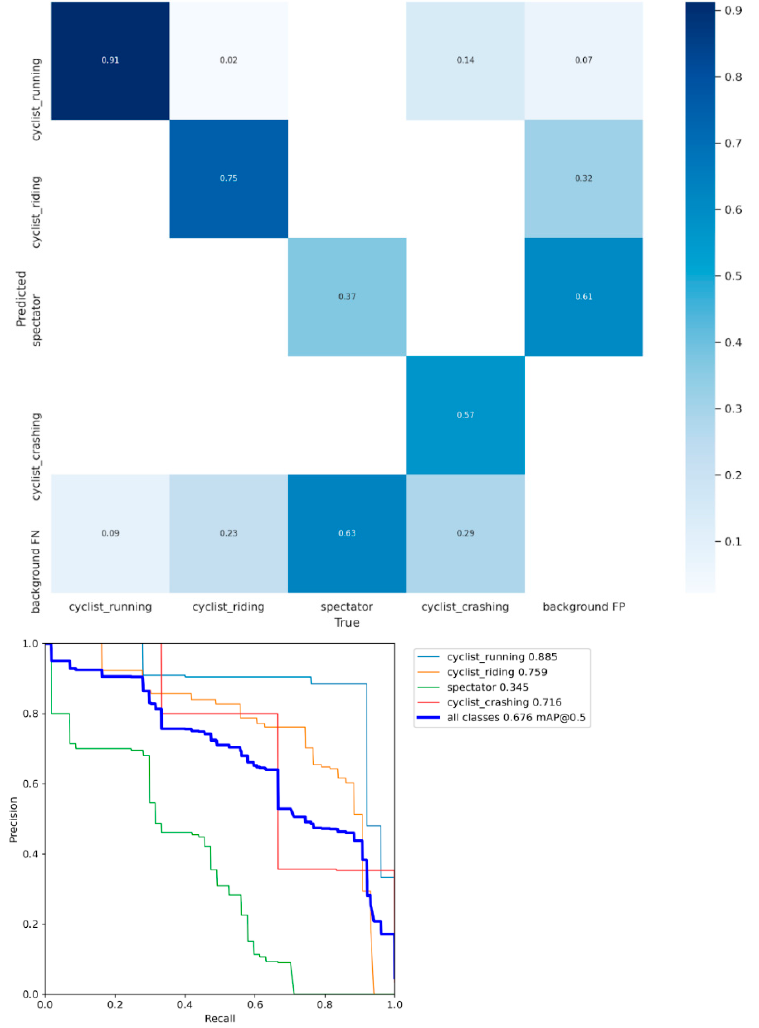
Figure 6. Confusion matrix and precision recall curve for the rider mode detector. As can be seen, the green line of spectators is performing significantly worse than the other